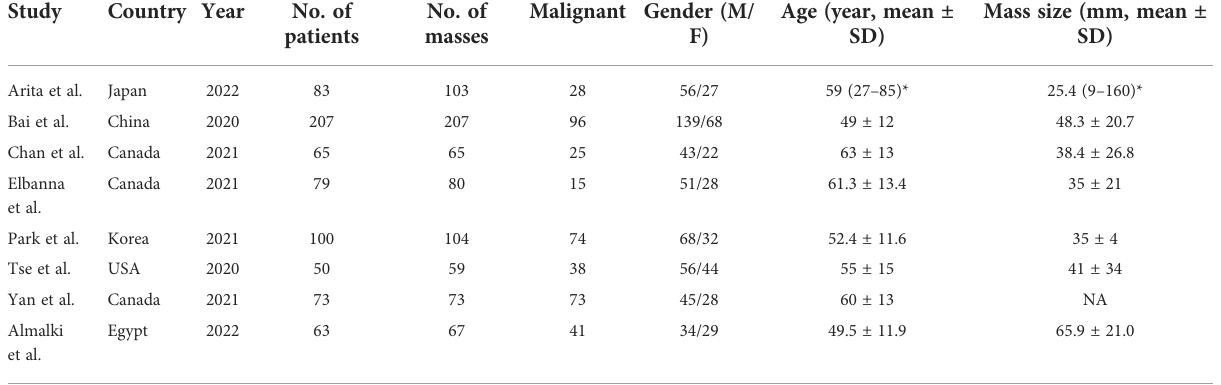
TABLE 1 Demographic characteristics of the included